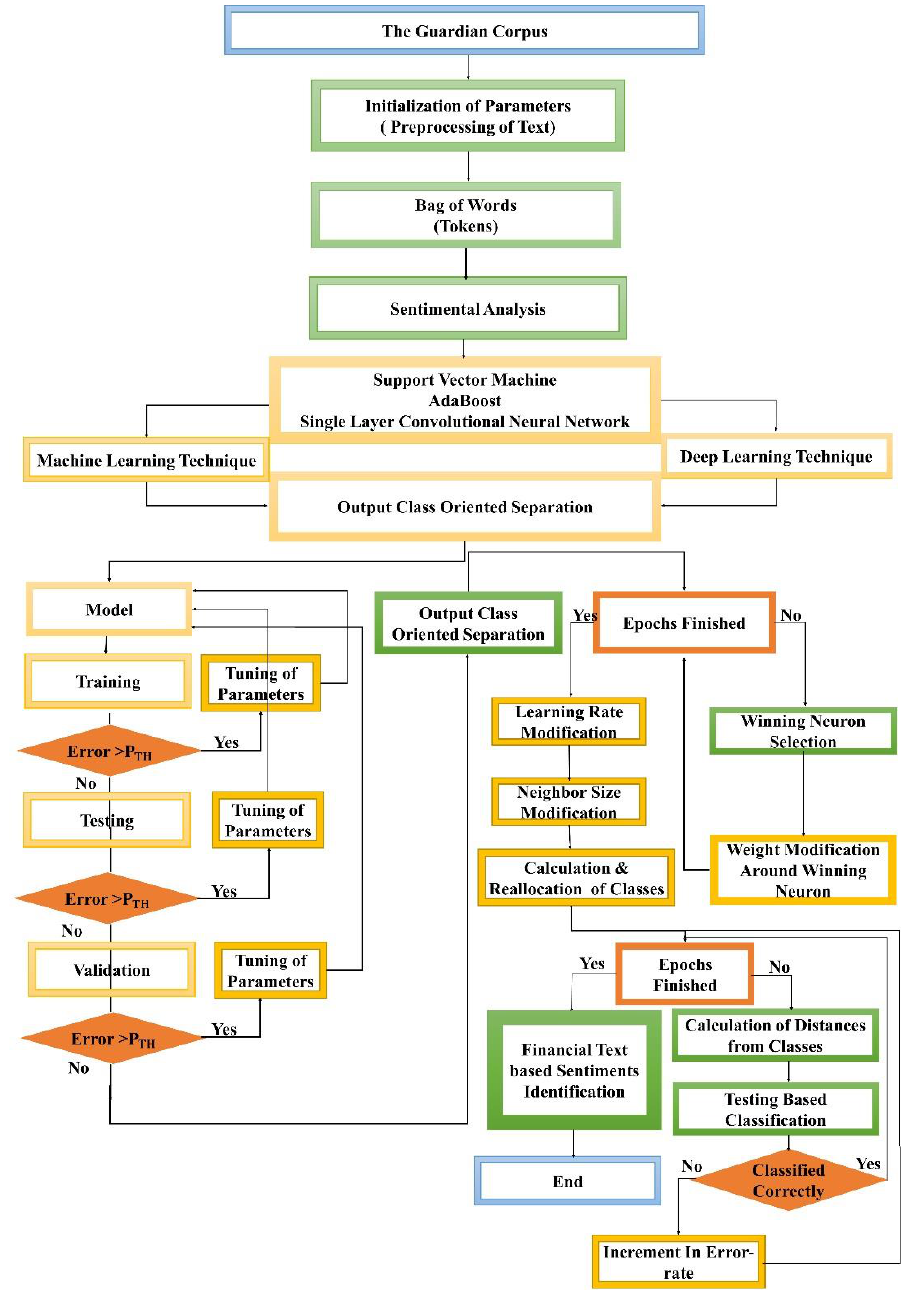
Figure 7. Detail Flowchart of Proposed Work. Table 5. Text based sentimental